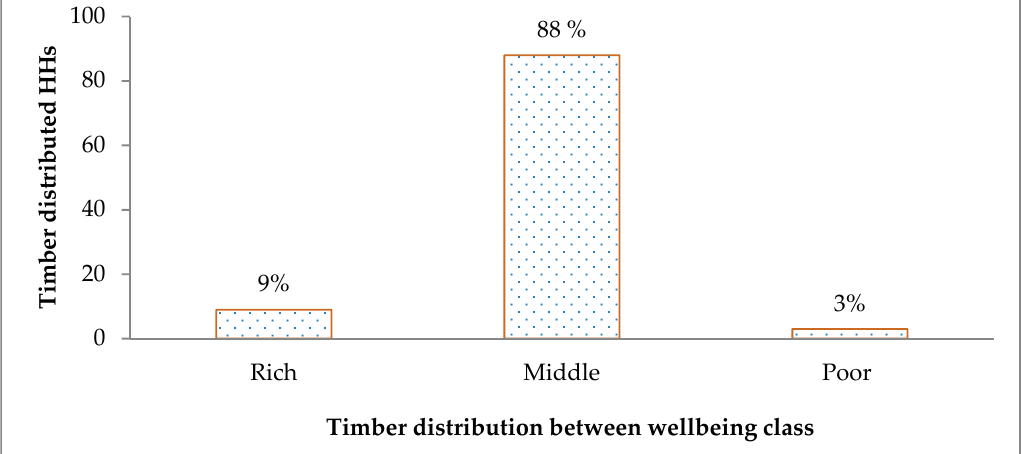
Figure 5. Timber distribution between wellbeing classes after SciFM implementation.